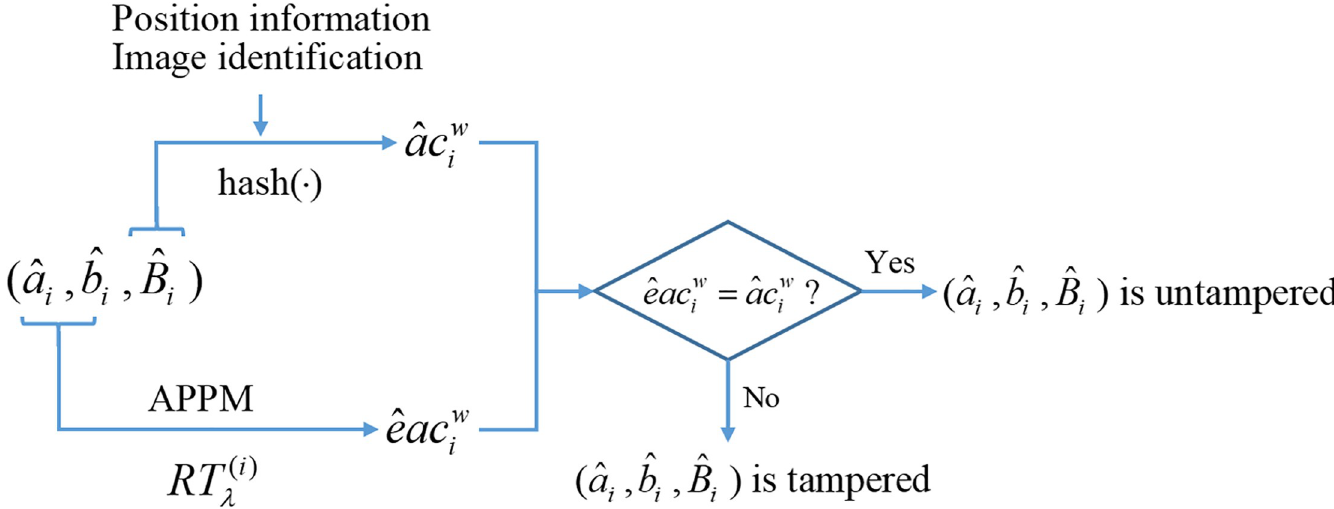
Fig 5. The schematic diagram of authentication procedures.